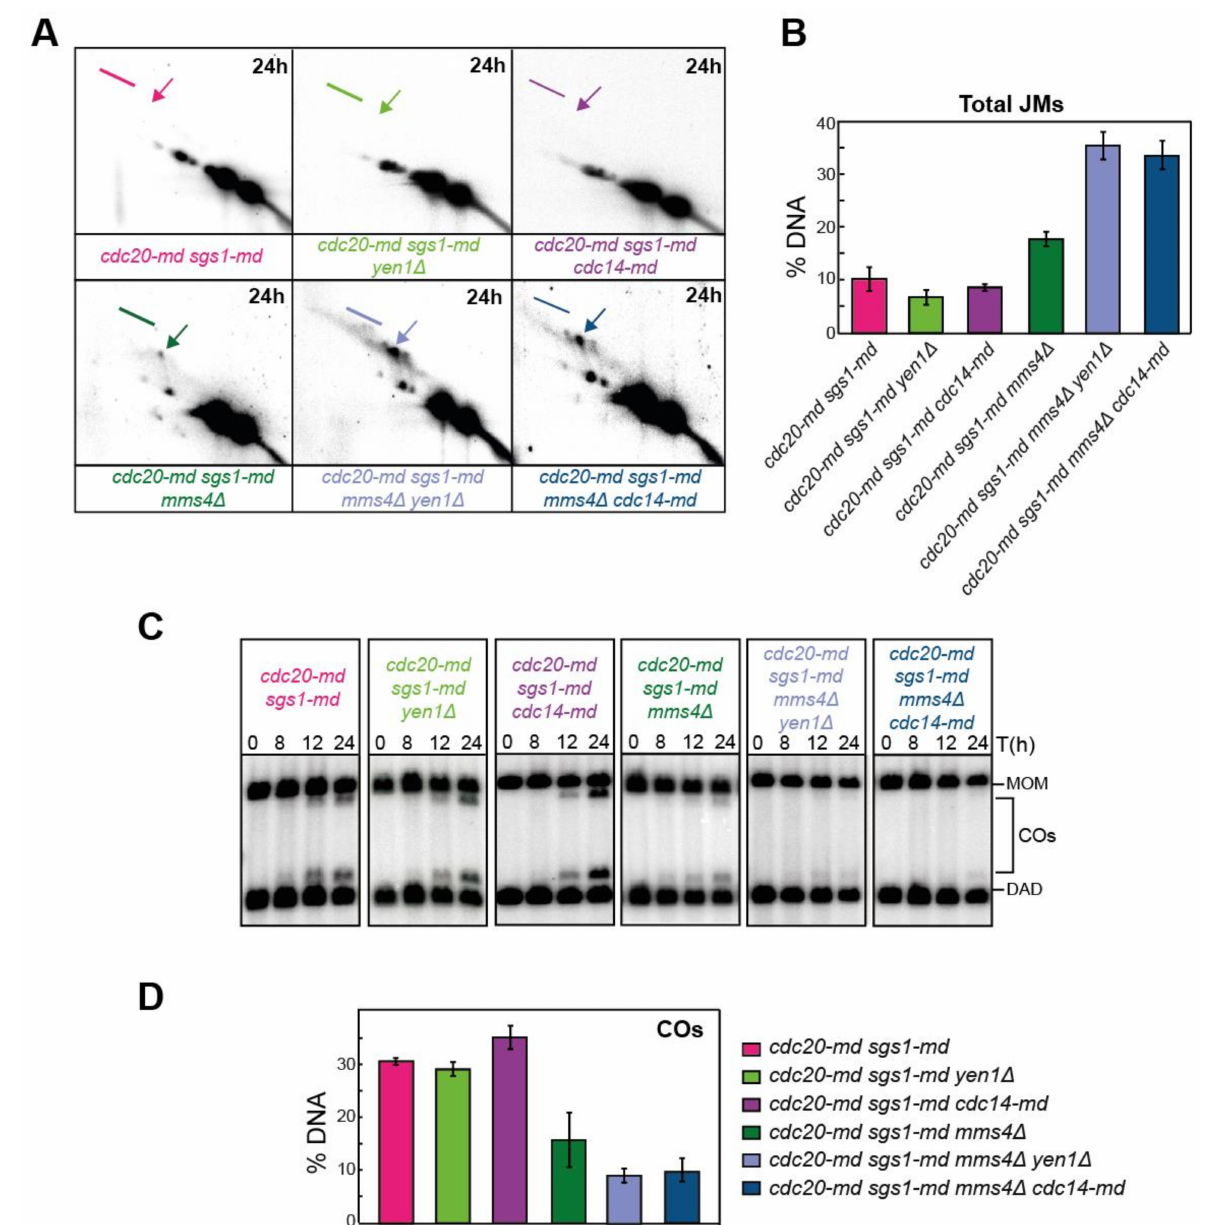
Figure 7. Analysis of recombination intermediates in the cdc20-md mutant reveals an early meiotic role for Cdc14 and Yen1. ( A ) Representative Southern blots depicting 2D-gels at the HIS4LEU2 hotspot in CDC14 cdc20-md sgs1-md (JCY2480), cdc20-md sgs1-md yen1 (JCY2469), cdc20-md sgs1-md cdc14-md (JCY2508), cdc20-md sgs1-md mms4 (JCY2480), cdc20-md sgs1-md mms4 yen1 (JCY2478) and cdc20-md sgs1-md mms4 cdc14-md (JCY2502). Arrows mark IH-dHJs and lines mark mc-JMs (see Figure 4A,B). ( B ) Quantification of total JMs in the strains shown in ( A ) from several independent gels. Error bars display SEM over the mean values plotted. ( C ) Representative 1D-gel Southern blot images for analysis of crossovers at the HIS4LEU2 hotspot for all strains shown in ( A ). ( D ) Quantification of COs from at least three different image acquisitions, such as that depicted in ( C ). Error bars represent SEM over the calculated mean